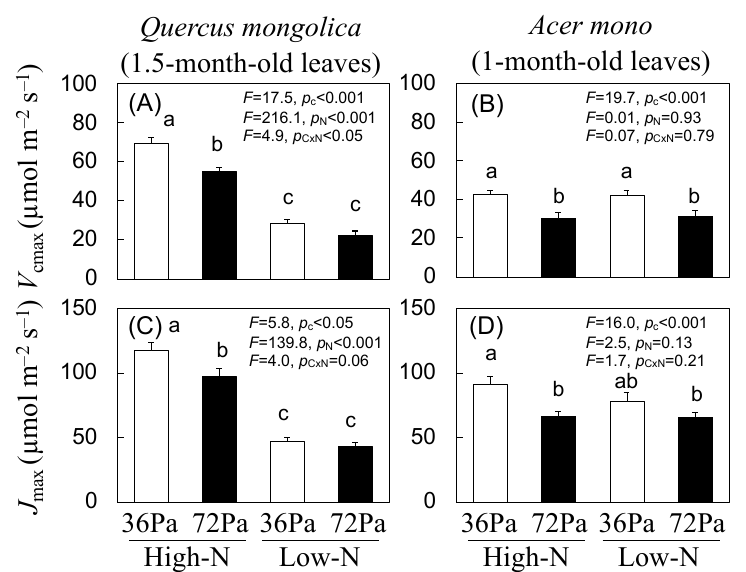
Figure 1. Maximum carbon fixation rate ( V cmax ) and maximum electron transfer rate ( J max ) of Quercus mongolica (1.5-month-old leaves) ( A , C ), and Acer mono ( B , D ). Means and standard errors are shown ( n = 5–9). Ambient CO 2 : 36 Pa; elevated CO 2 : 72 Pa. F -value and probability ( p ) of the effects of CO 2 ( p C ), N ( p N ), and their interaction ( p CxN ) are indicated in the panel. Lowercase letters represent mul- tiple comparison results among four treatments when the treatment effects are significant at p < 0.05.